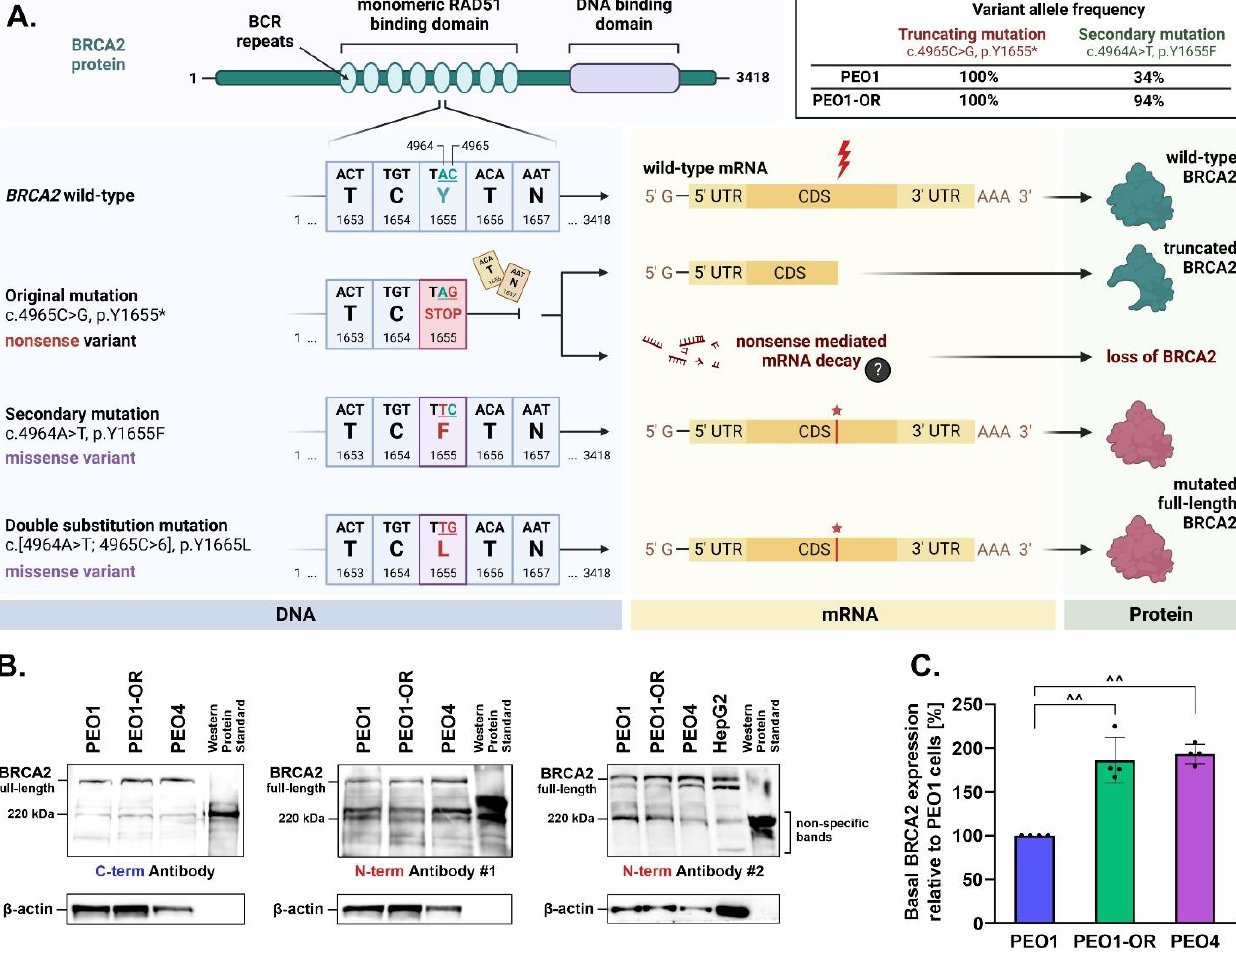
Figure 3. Restoration of wild-type BRCA2 open reading frame by secondary reversion mutation promotes upregulation of BRCA2, potentially accounting for olaparib resistance in PEO1-OR cells. ( A ) Schematic representation of the biochemical consequences of key BRCA2 variants detected using WES. PEO1-OR and PEO1 cells are homozygous for a truncating mutation (c.4965C > G, p.Y1655 *). Co-occurrence of a secondary mutation (c.[4964A > T; 4965C > G], p.Y1655L) removes the premature stop codon introduced by the truncation mutation originating from the PEO1 cell line, restoring the wild-type ORF of BRCA2. ( B ) Qualitative Western blot analysis of full-length and truncated BRCA2 in OC cells. The HepG2 cell line was used as a negative control of truncated BRCA2 expression to exclude non-specific bands. An anti-BRCA2 antibody against the C-terminus and two antibodies against the N-terminus (targeting different epitopes) were used to differentiate between the two protein forms. ( C ) Quantitative Western blot analysis of basal expression of full-length BRCA2 in OC using a monoclonal antibody against the N-terminus #2. The results are expressed as mean ± SD ( n = 4). Statistical significance was assessed using ordinary one-way ANOVA followed by Tukey’s test. ˆˆ p < 0.01: differences between cell lines. CDS—coding sequence, UTR—untranslated